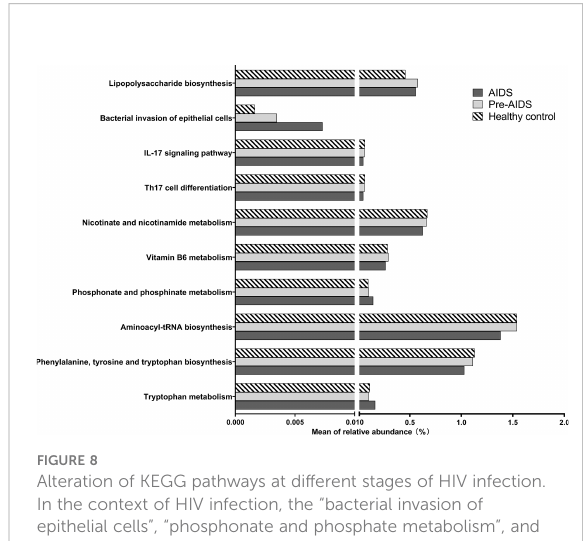
FIGURE 8 Alteration of KEGG pathways at different stages of HIV infection. In the context of HIV infection, the “ bacterial invasion of epithelial cells ” , “ phosphonate and phosphate metabolism ” , and “ tryptophan metabolism ” and pathways were up-regulated in AIDS group, while the “ vitamin B6 metabolism ” pathways were down-regulated (FDR P<0.1). The “ IL-17 signalling pathway ” , “ Th17 cell differentiation ” , “ nicotinate and nicotinamide metabolism ” , “ aminoacyl-tRNA biosynthesis ” , and “ phenylalanine, tyrosine and tryptophan biosynthesis ” showed a downward trend with the severity of the disease (FDR